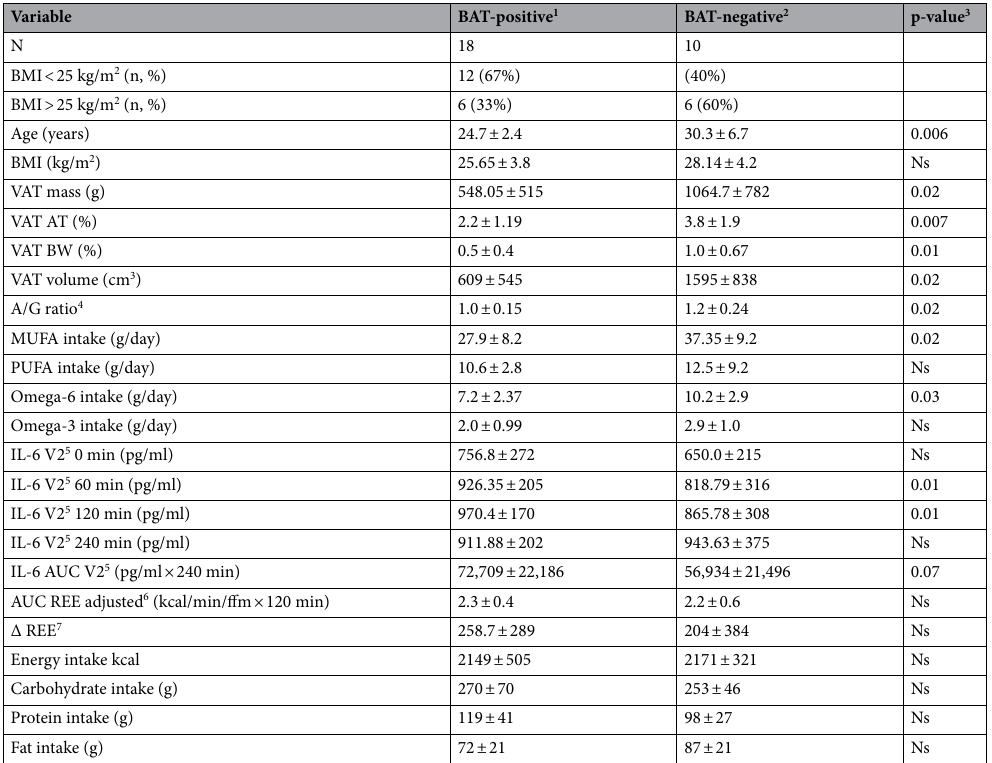
Table 1. Characteristics of BAT-positive and BAT-negative group. The parameters in the table are represented by its means and standard deviations. 1 BAT-positive—a group of subjects in whom brown adipose tissue was detected; 2 BAT-negative—a group of subjects without detectable brown adipose tissue; 3 p value—adjusted for age, daily average kcal intake, DXA Lean mass; 4 A/G ratio, android to gynoid ratio; 5 V2—the second visit— cooling exposure with PET-MR; 6 AUC whole-body energy expenditure adjusted for age, daily kcal intake, DXA Lean mass, 7 a change of whole-body resting energy expenditure between 0 and 120 min of cold exposure; BMI body mass index, VAT mass the visceral adipose tissue mass, VAT AT (%) the visceral adipose tissue percentage of adipose tissue, VAT BT (%) the visceral adipose tissue percentage of body weight, VAT volume